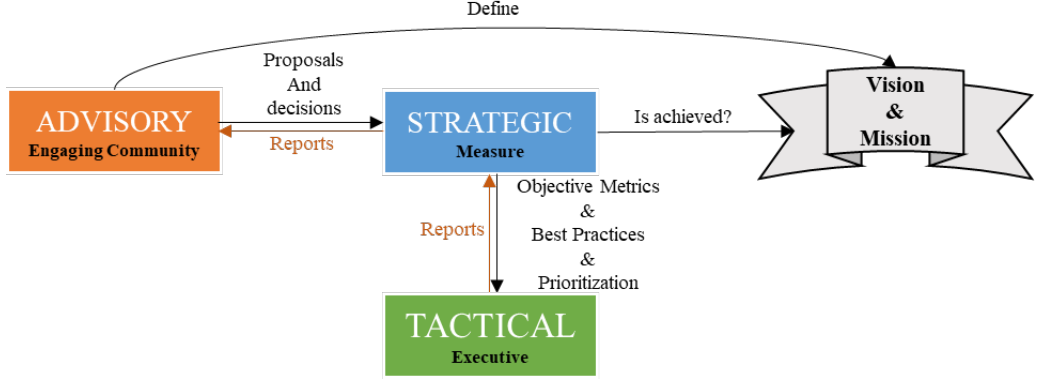
Figure 6. Areas and information exchange.